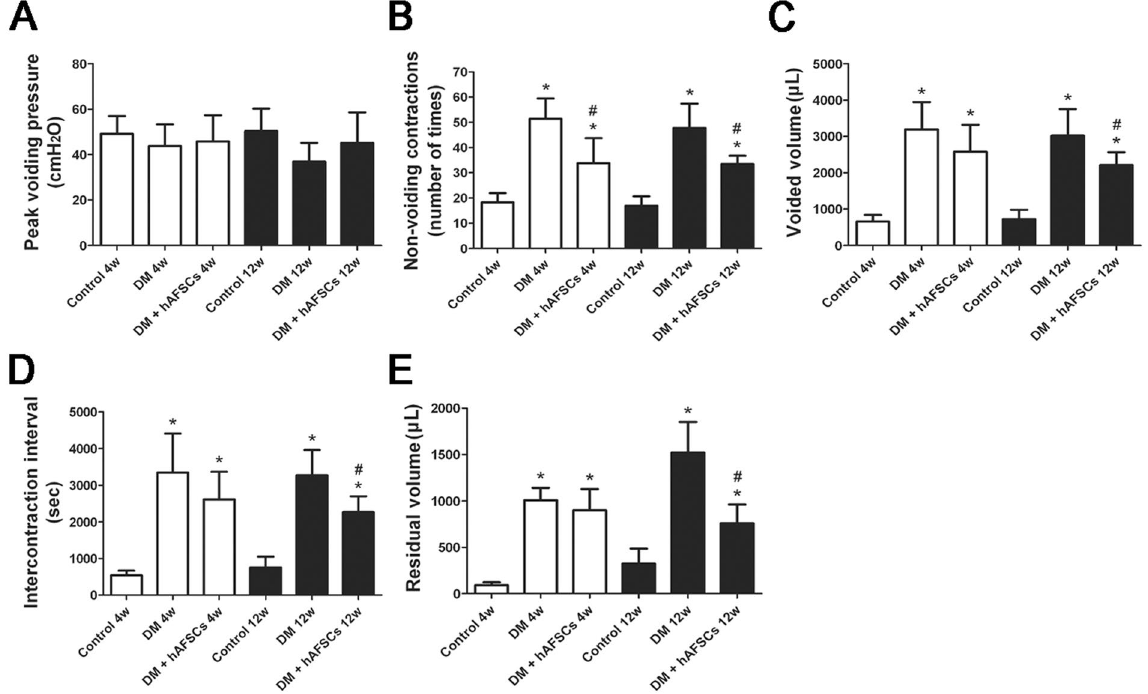
Figure 2. Cystometric results in the control, STZ-induced diabetic rats (DM) and diabetic rats + hAFSCs transplantation (DM + hAFSCs) are presented. Cystometric variables include peak voiding pressure ( A ), nonvoiding contractions ( B ), voided volume ( C ), intercontraction interval ( D ), and residual volume ( E ). Bladder dysfunction of the STZ-induced diabetic rats can be improved after hAFSCs transplantation. * P < 0.05 vs. control group. # P < 0.05 vs. diabetic rat. N = 10 in each time point.